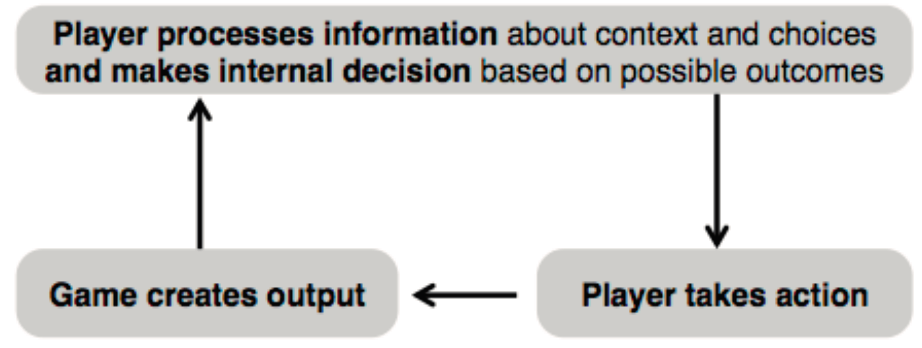
Figure 2. The learning experience through gameplay (from Mendler de Suarez et al. [12], based on Salen and Zimmerman